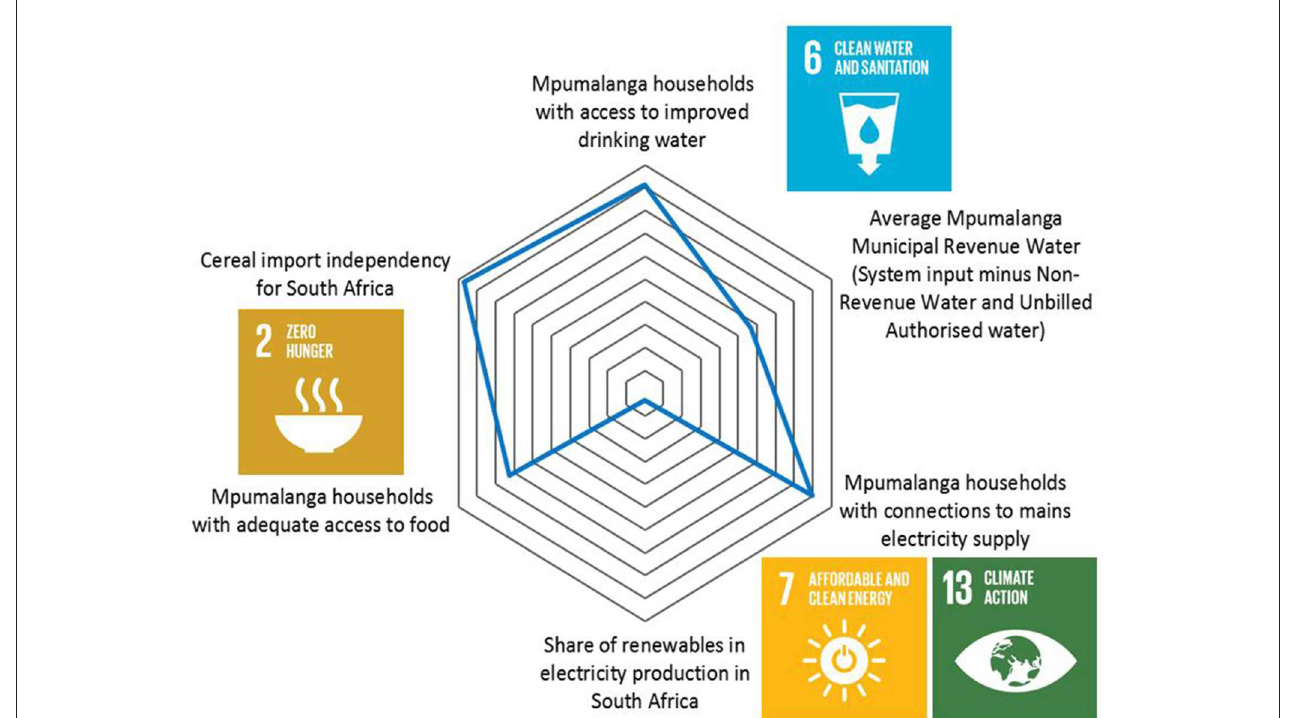
FIGURE 4 | Radar chart of two indicators for each of the WEF resource sectors (Lotter, 2010).